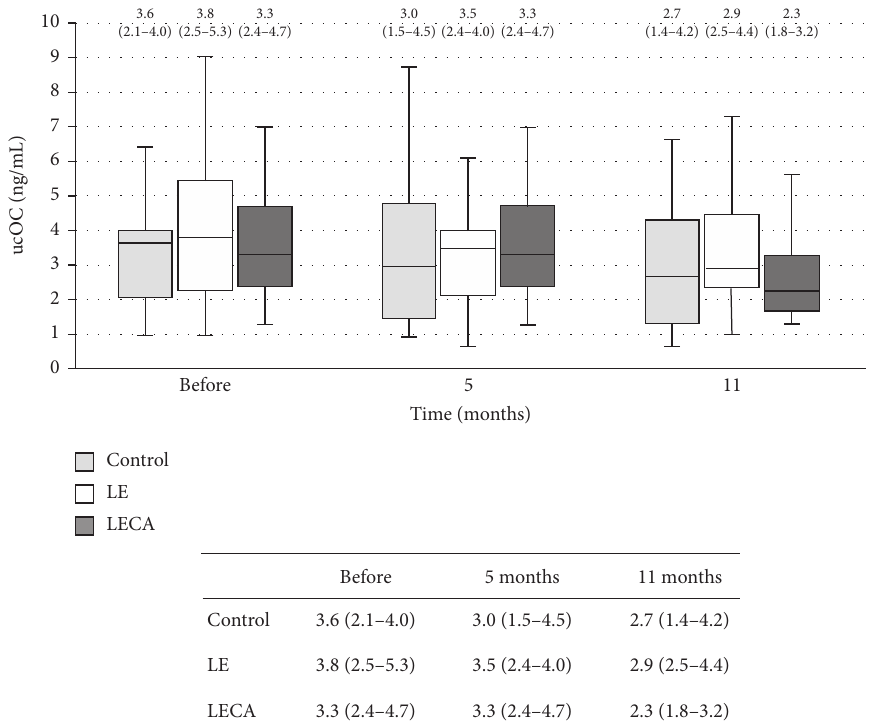
Figure 4: Changes in ucOC concentrations in each group (chronological). Values are shown as the median (interquartile range) (25%–75%) with error bars. Light grey box is the control group, blank box is the LE group, and dark grey box is the LECA group. Friedman’s test with type of ingested product and intervention period as factors was used. p values for each group are shown ( ‡ ). Control: p � 0.664 ‡ ; LE: p � 0.214 ‡ ; LECA: p < 0.001 ‡ . ucOC: undercarboxylated